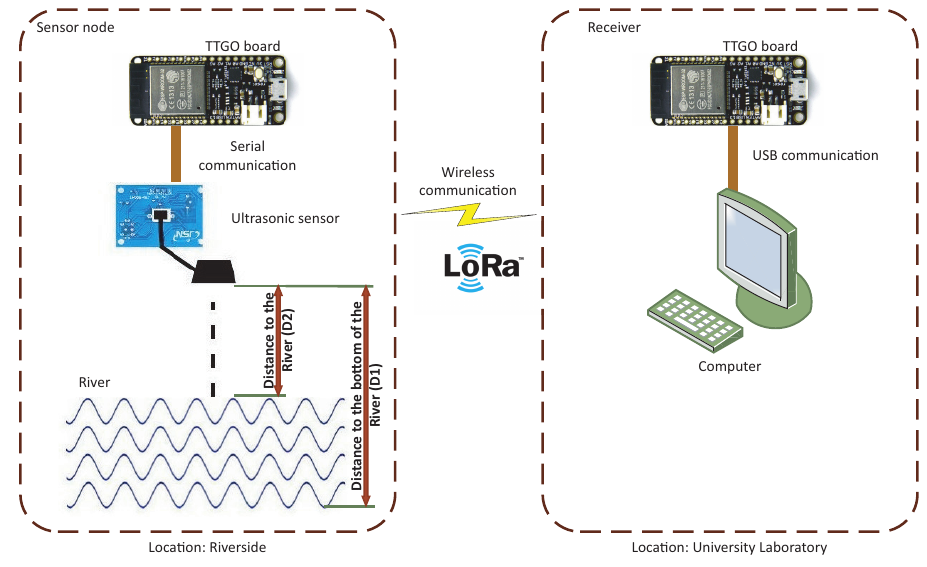
Figure 2. Current architecture